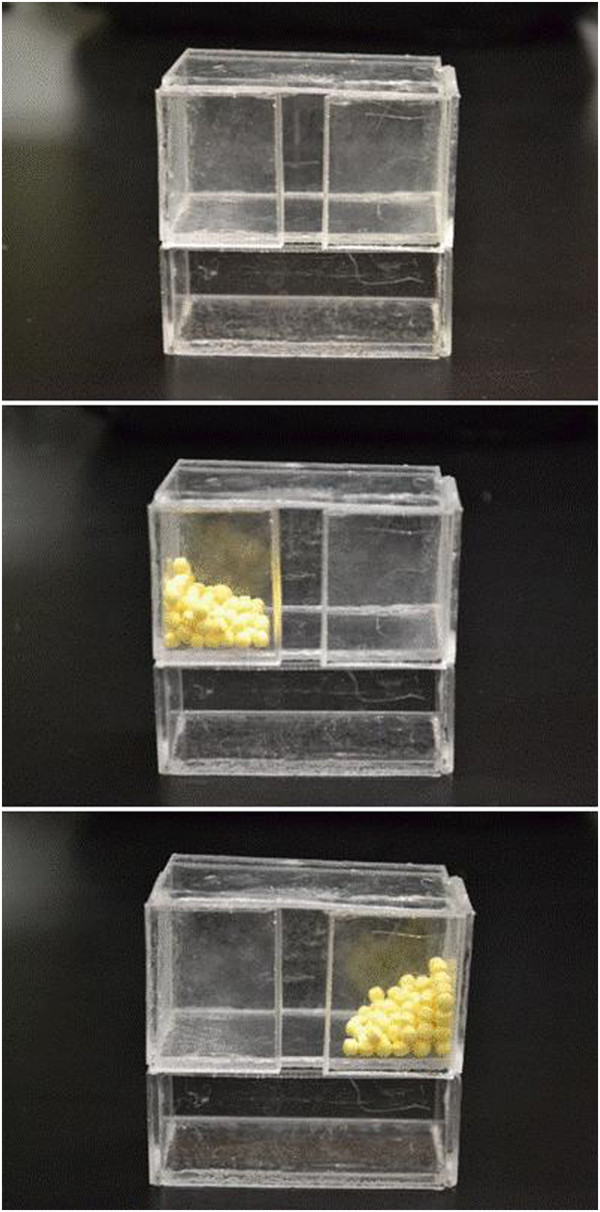
A task-specific reaching exercise can be administered using an apparatus such as this. By piling palatable sugar pellets to one side of the box (opposite from the impaired forelimb) rats are encouraged to use the impaired limb to reach through the center slot. The intensity can be altered by controlling the accessing time, number of pellets, and height of the reaching box.